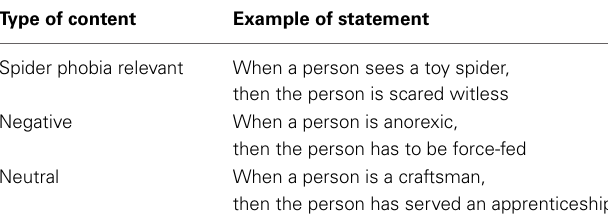
Table 2 | Examples of statements with different